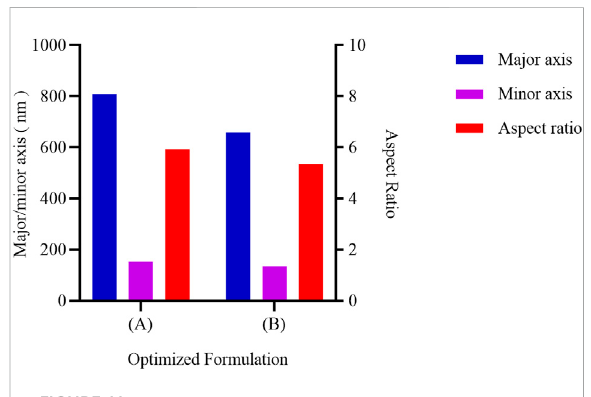
FIGURE 11 The size and aspect ratio of PLGA nanorods prepared with optimized formulation. The left vertical axis shows the mean major/minor axis, the right vertical axis shows the mean aspect ratio. (A) The PVA 1 concentration of .1 wt%; (B) The PVA 1 concentration of 1.0